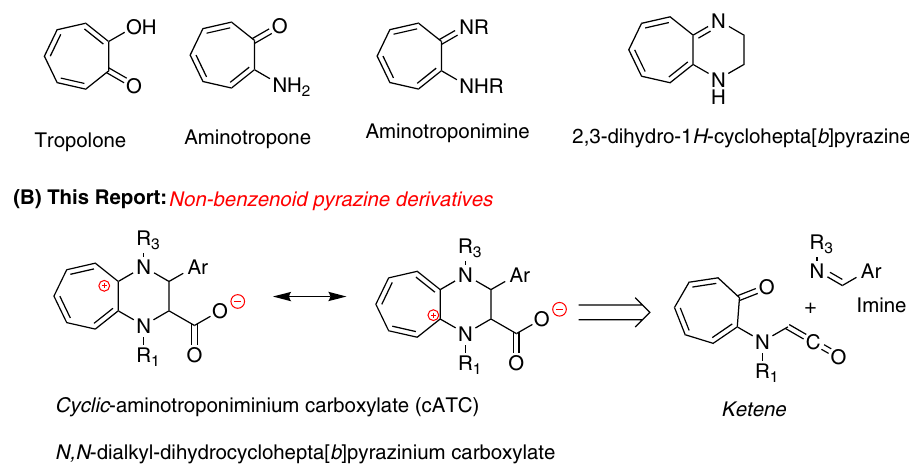
Fig. 1 Chemical structures of Tropolone derivatives. A Previously reported Troponyl derivatives. B Rationally designed cATC